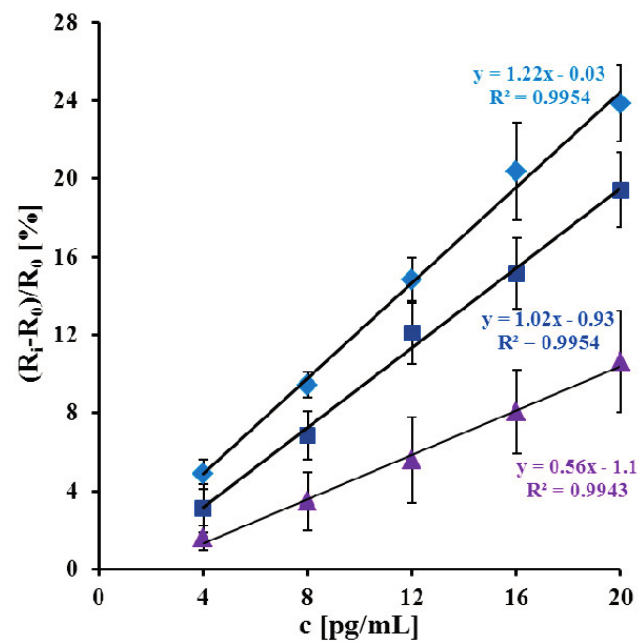
Figure 5. The relationship of ( R ( ■ ) HA/Nde and ( ▲ ) Vietnam polypeptide. R modified electrode measured in pure PBS buffer before antigen application and R electron transfer resistance of fully modified electrode measured in 0.1 M PBS buffer with the given concentration of antigen (n =